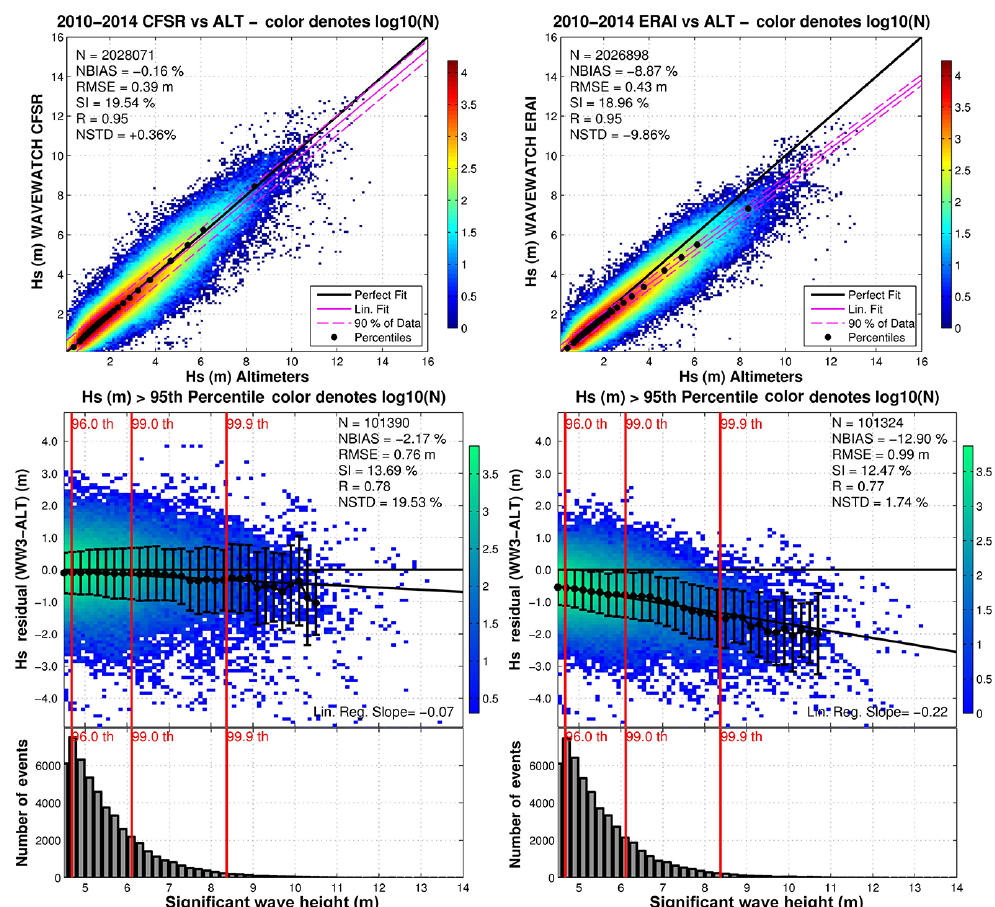
Figure A2. Significant wave height comparison from CFSR (left) and ERAI (right) versus co-located data from altimeters. The error dis- persion of the models is presented in a scatter plot with the density given in a logarithmic scale (top panels). The upper percentiles are highlighted to show the differences (bottom